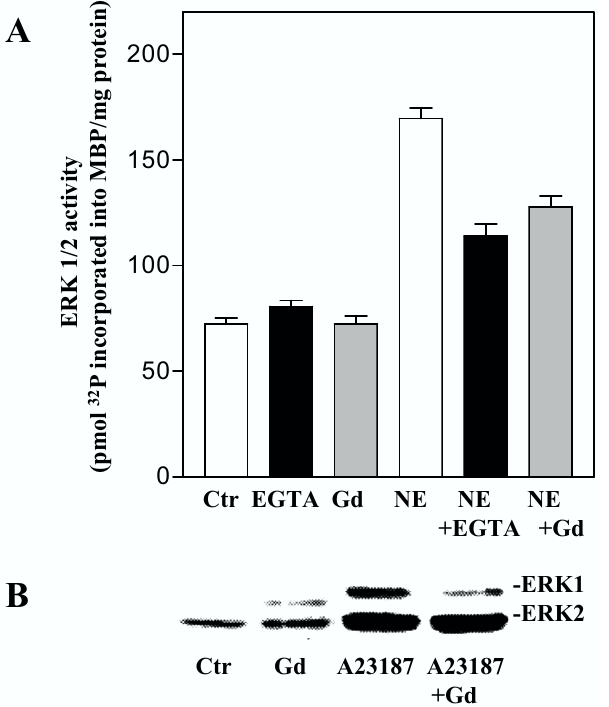
Figure 4 Effect of gadolinium on ERK1/2 responses. A: Hepatocytes cultured for 3 h were pretreated with gadolinium (100 µ M) or EGTA (5 mM) for 15 min in the presence of timolol (10 µ M) prior to stimulation with norepinephrine (10 µ M) for 5 min before cells were harvested. Results are activity meas- urements of ERK1/2 given as pmol 32 P incorporated into MBP/mg protein representing mean ± S.E.M. of three experi- ments. B: Immunoblot showing the effect of pretreatment with gadolinium (100 µ M) for 15 min on A23187 (10 µ M) induced ERK1/2 response. Antibody against dually phosphor- ylated ERK1/2 was